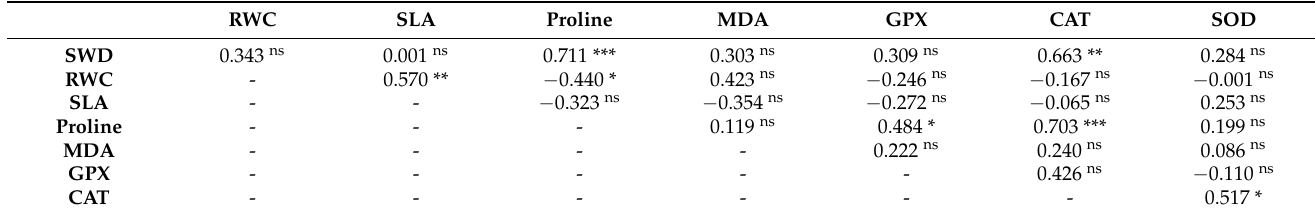
Table 4. Pearson’s correlation test among traits (genotype: ‘Custonaci’). Significant at p ≤ 0.05 (*), 0.01 (**), and 0.001 (***); not significant (ns).